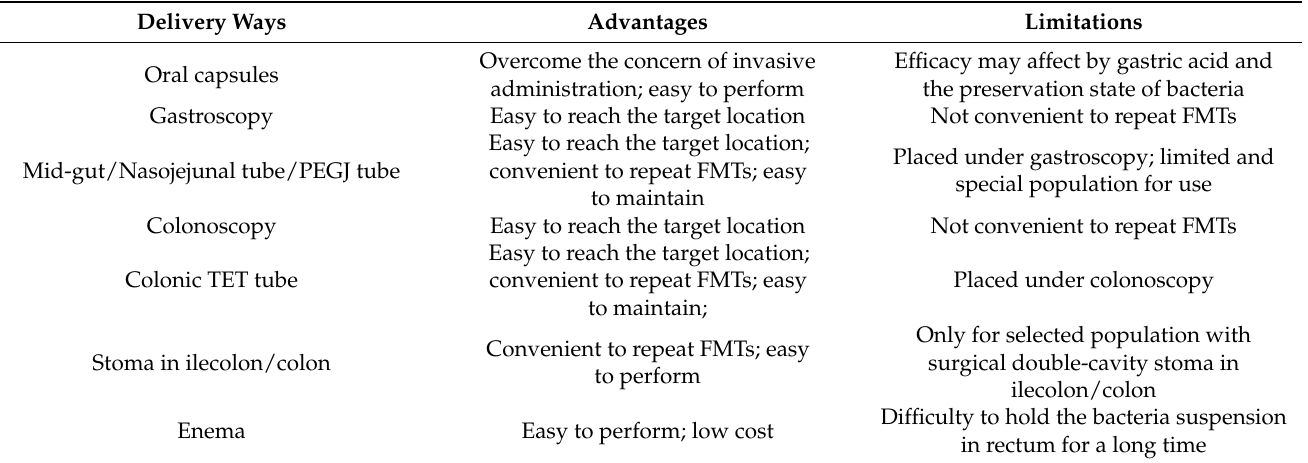
Table 1. Comparison of the different delivery